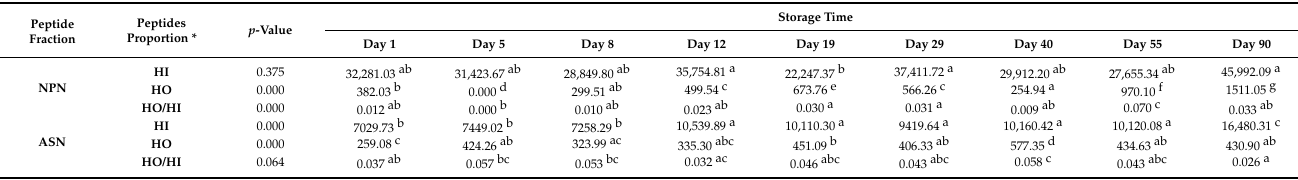
Table 1. ANOVA and Fisher’s LSD test ( p < 0.05) of % area of hydrophobic (HO), hydrophilic (HI) peptides, and the ratio (HO/HI) in the nitrogenous fractions throughout all ripening processes in Mexican goat cheese. Peptide